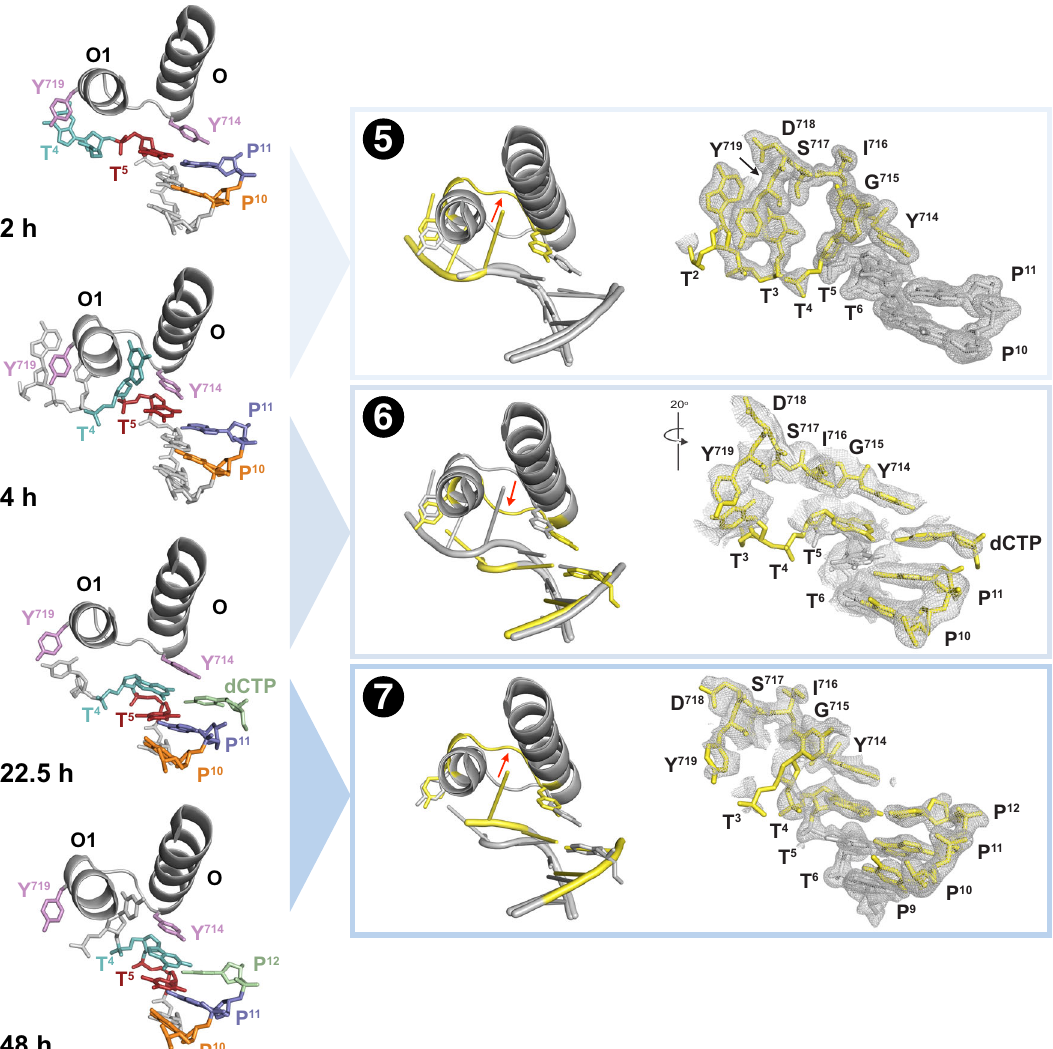
Fig. 2 Time-lapsed images capture the elongation step of DNA synthesis. X-ray crystal structures of polymerase intermediates observed between 2 – 48 h (left column). Cartoon overlays and polder maps contoured at 2 – 4 σ (blue boxes). Red arrow indicates conformational changes between structures. The transitions are labeled: (5) opening of the O-O1 loop to form a hydrophobic pocket, (6) closing of the O-O1 loop, and (7) reopening of the O-O1 loop following chemical bond formation. Color scheme: 5 ’ templating base (cyan), Y714 and Y719 (purple), 3 ’ nucleotide of DNA primer (blue, dCTP (green), earlier reaction time (gray), and later reaction time (yellow). Abbreviations: O (O helix), O1 (O1 helix), T (template), P (primer), Y (tyrosine), D (aspartate), S (serine), I (isoleucine), and G